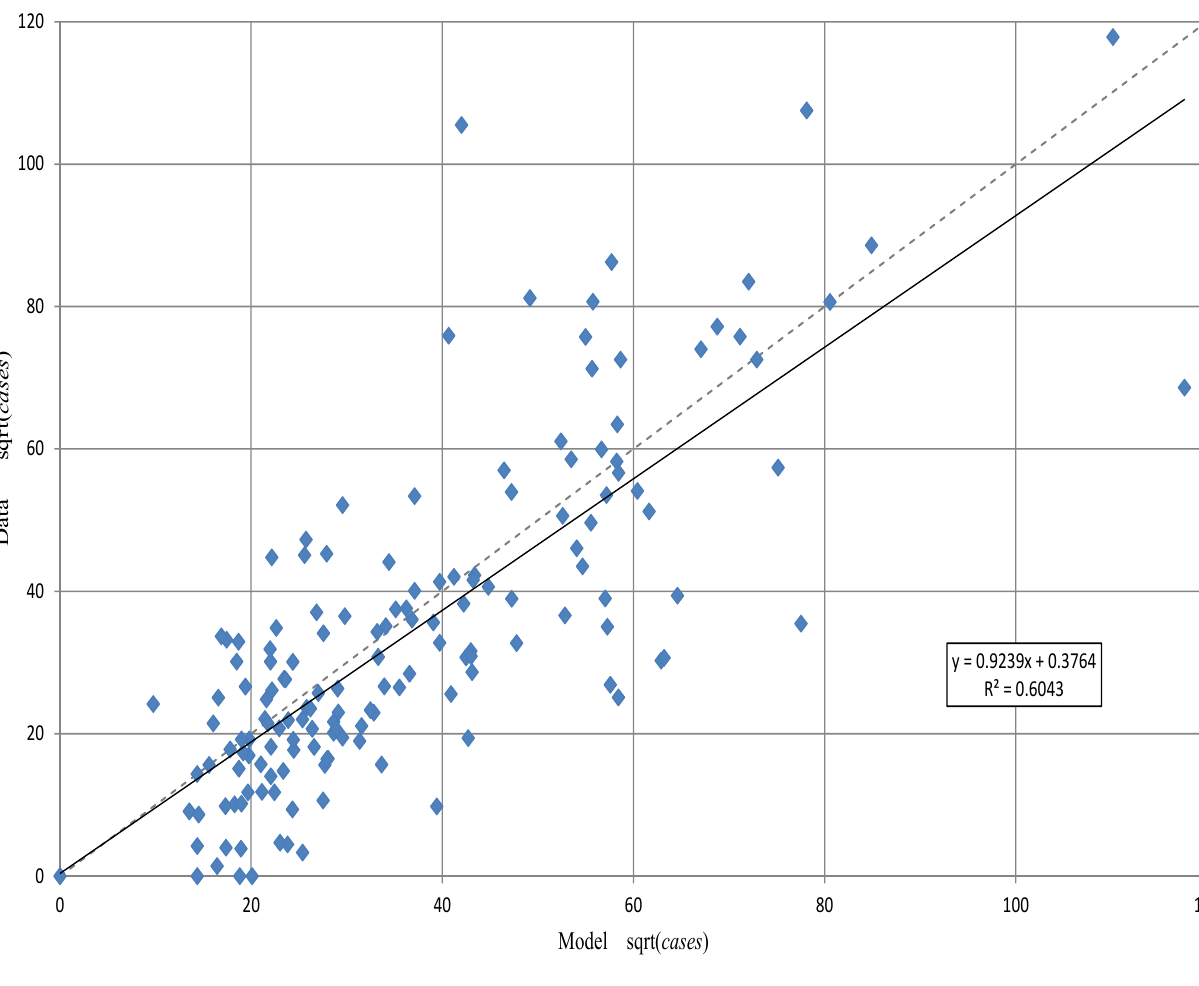
Figure 7. Ouest. The predicted new symptomatic individuals, against weekly reported cases to 1 April 2012 (square root transformed). A regression line matching the 45 ◦ line would show an optimal fit, the discrepancy is due in part to fitting on the cumulative numbers.